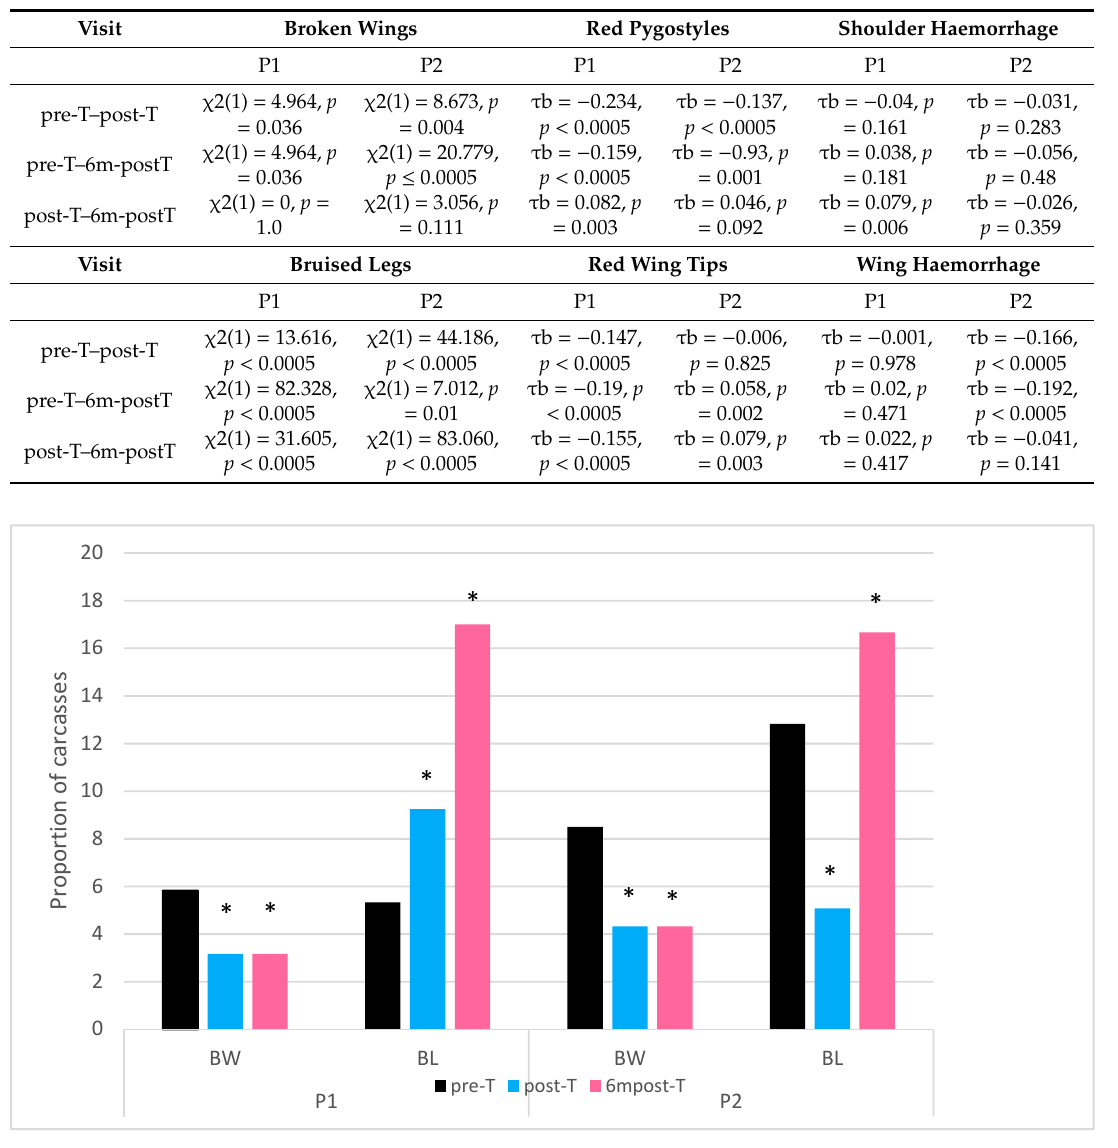
Figure 7. Proportion of carcasses with broken wings (BW) and bruised legs (BL). * represents a statistically significant difference in proportion from pre-training visit ( p ≤ 0.05) calculated using the exact Chi-squared test.